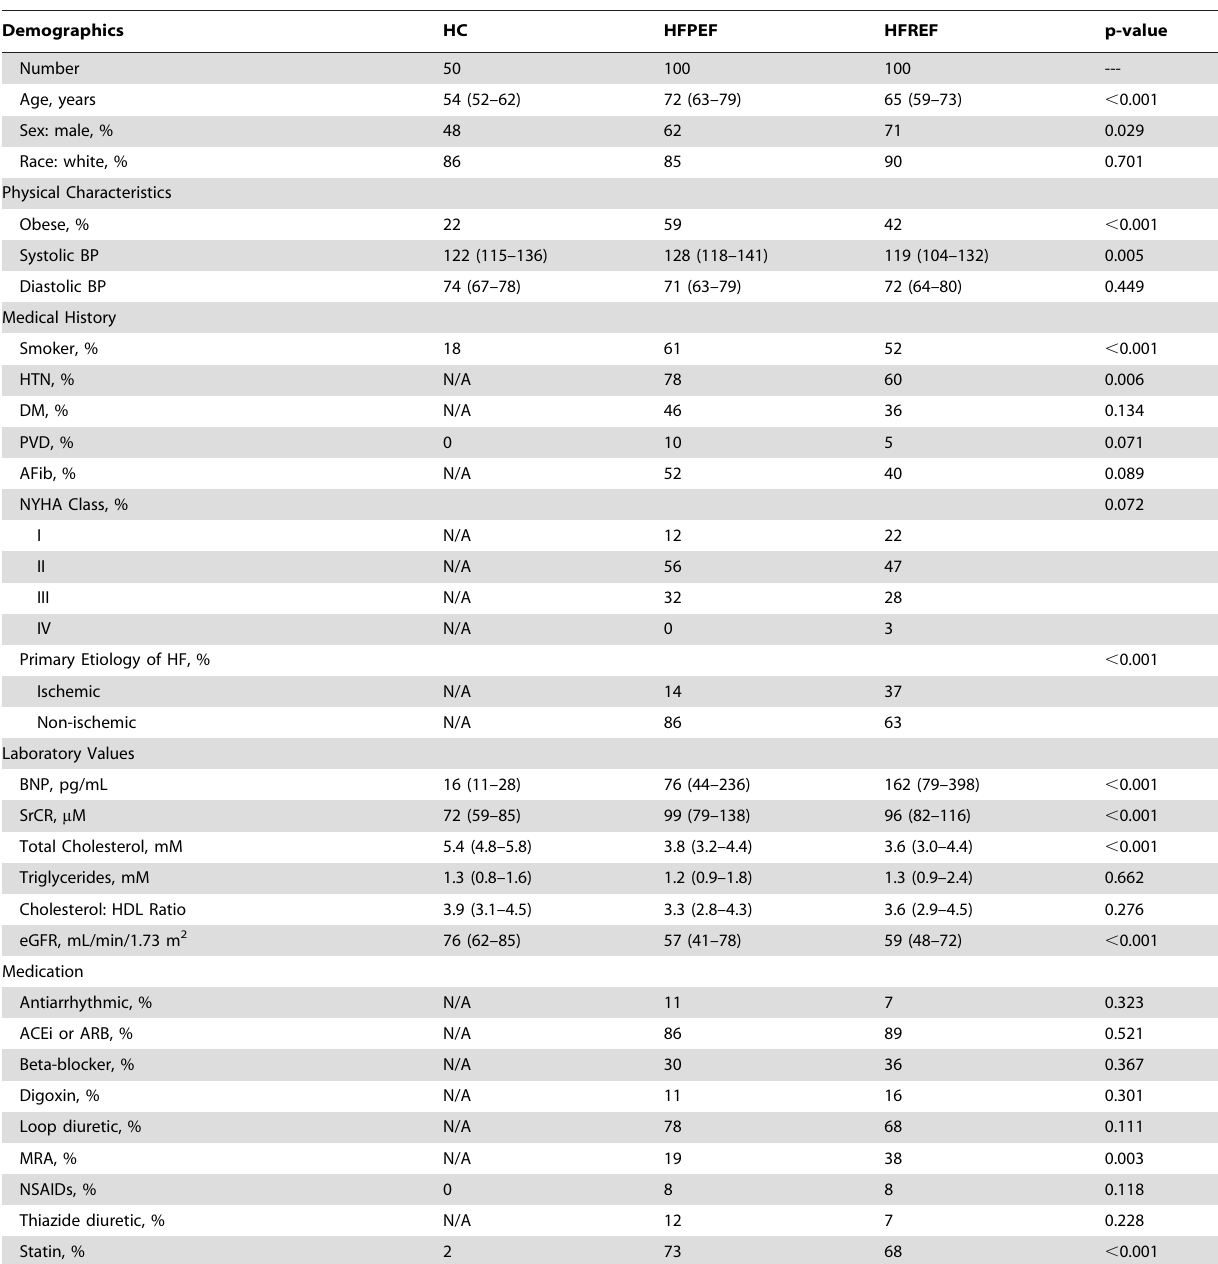
Table 1. Baseline clinical